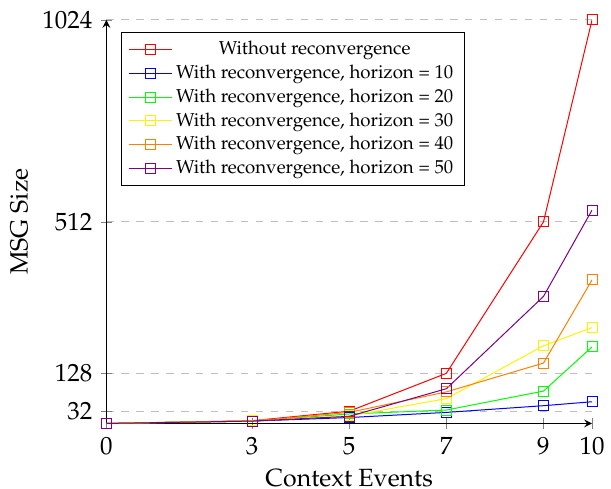
Figure 8. MSG with reconvergence for 40